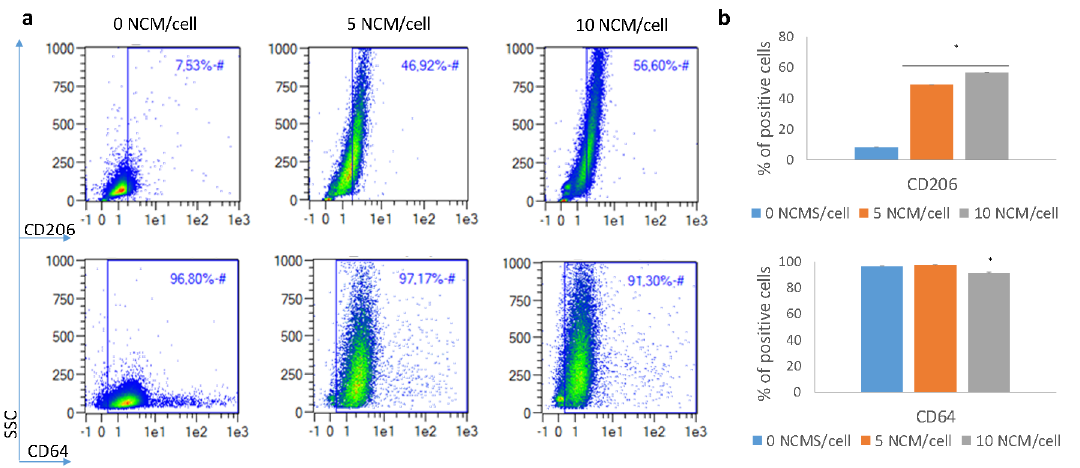
Figure 5. Surface marker changes when M0 macrophages were incubated with 5 and 10 NCM/cell. ( a ) Representative flow cytometry density plots. ( b ) Percentage of positive cells for each marker. * p < 0.05.